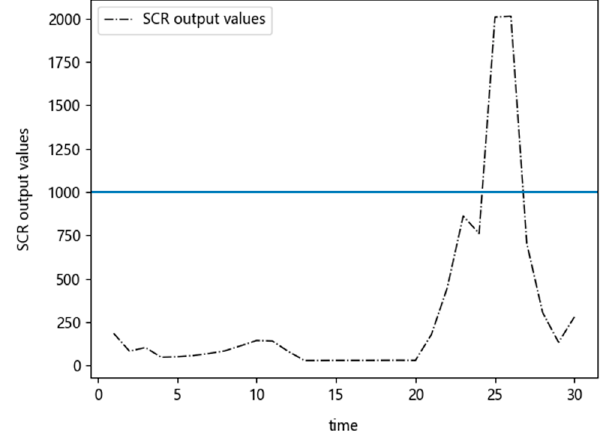
Figure 7. The raw data of NO x from the SCR downstream sensor over 30 s (note that the solid line is the threshold, beyond which the emission is regarded as excessive emission). Table 2. Results obtained by the three methods for the excessive emission determination.